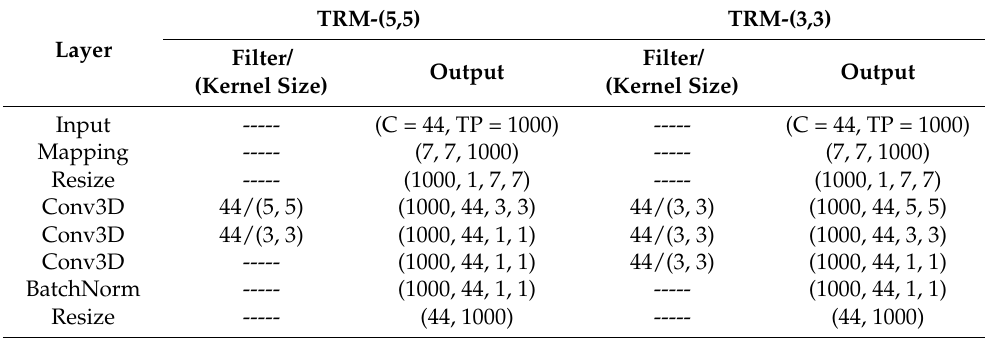
Table A2. The TRM architecture used on the